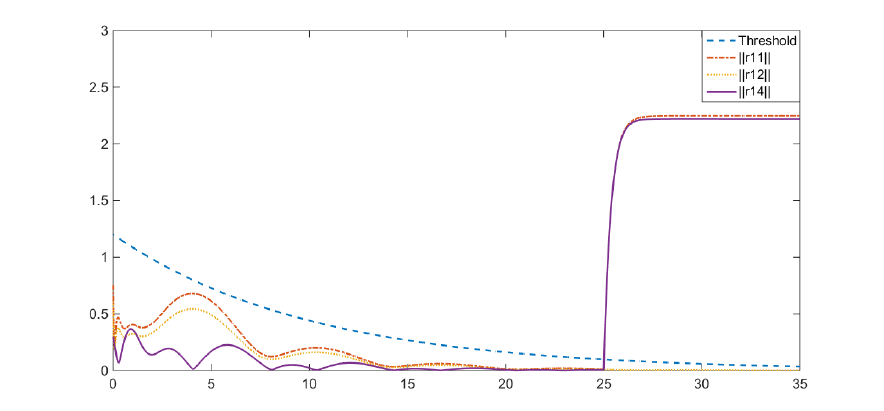
Figure 3. Residual generators in agent 1 under output